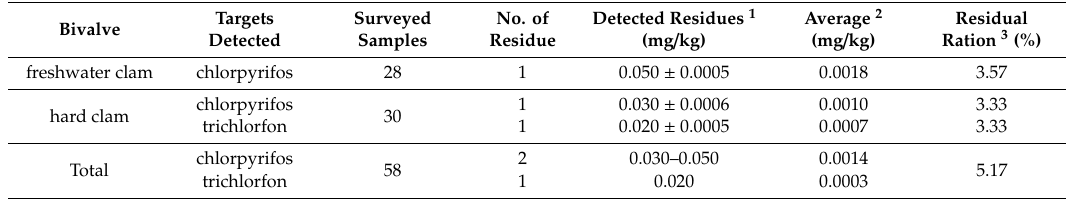
Table 2. Residual detection of banned organophosphorus insecticides in bivalve samples obtained